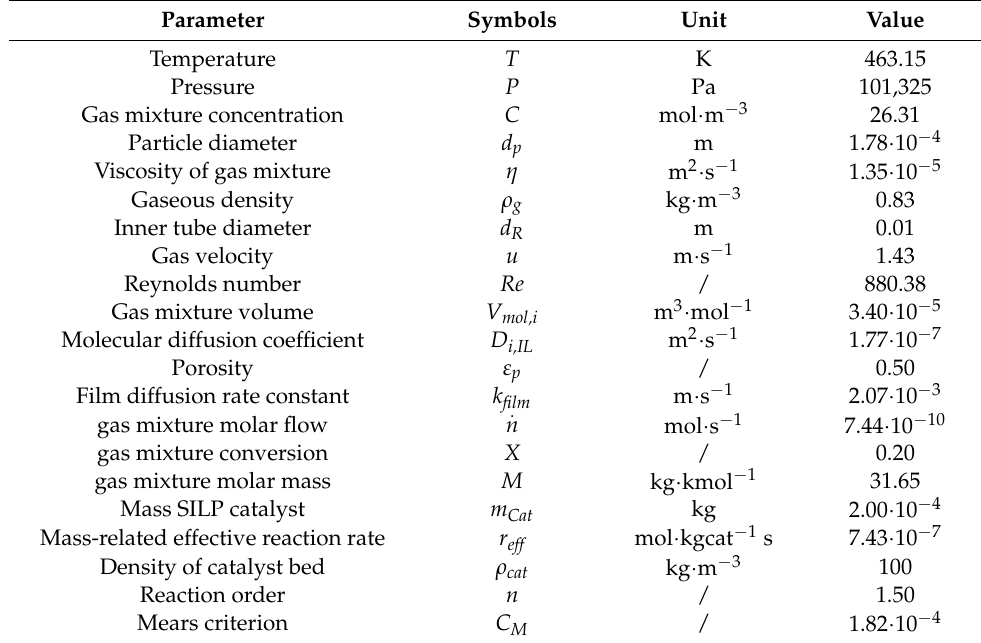
Table 1. The data points for film diffusion